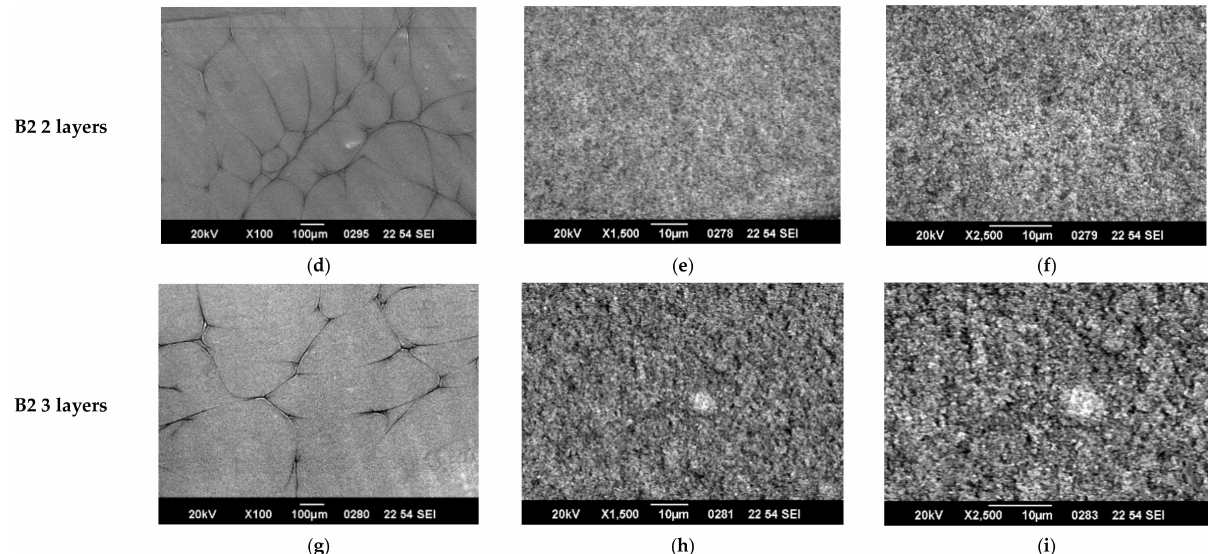
Figure 3. SEM characterization of 1, 2 and 3 layers of paint B2 at different magnifications. ( a ) B2.1 × 100 ( b ) B2.1 × 1500 ( c ) B2.1 × 2500 ( d ) B2.2 × 100 ( e ) B2.2 × 1500 ( f ) B2.2 × 2500 ( g ) B2.3 × 100 ( h ) B2.3 × 1500 ( i ) B2.3 × 2500.